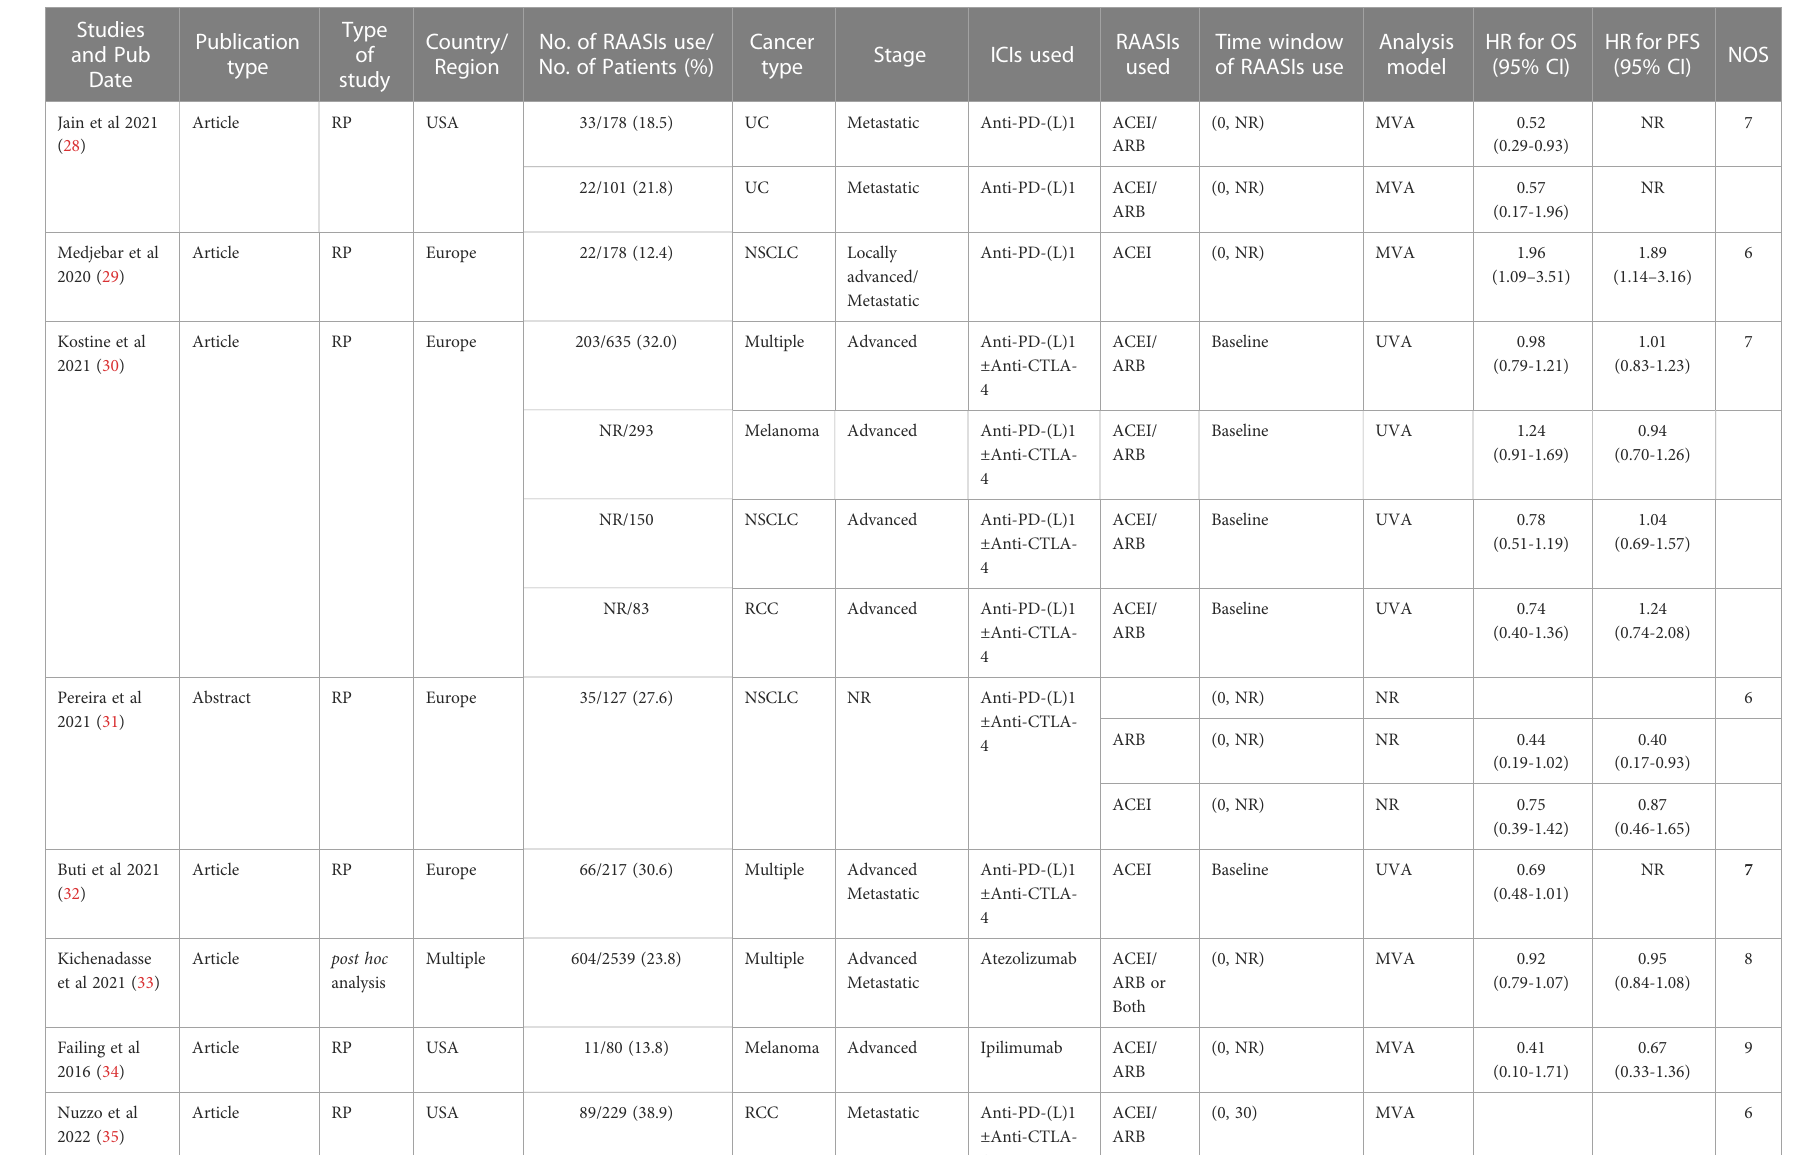
TABLE 1 Characteristics and quality assessment results of included